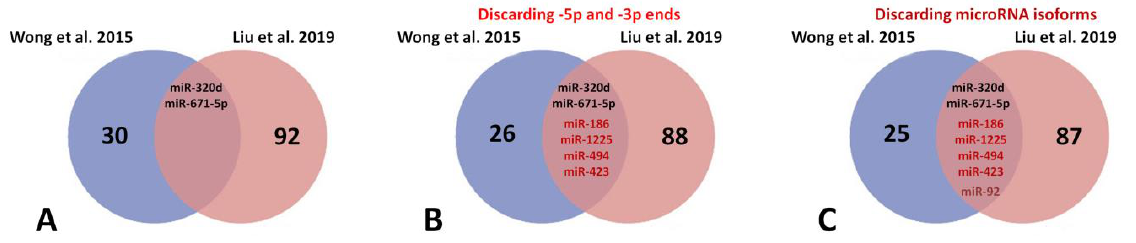
Figure 2. Venn diagram for analysis of commonly deregulated microRNAs related to heart failure in Wong et al. 2015 [64] and Liu et al. 2019 [65] studies: ( A ) mir-320d and miR-671 are commonly deregulated microRNAs in HF; ( B ) if -5p and -3p ends are discarded of the analysis, four new common microRNAs appear to be commonly deregulated; miR-186, miR-1225, miR-494 and miR-423; ( C ) finally, discarding microRNA isoforms of only one new common microRNA, miR-92, is deregulated in